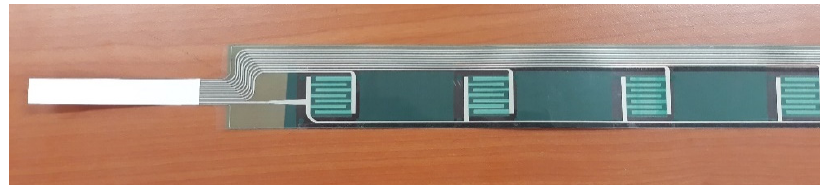
Figure 5. The belt-shaped force-sensing resistor.